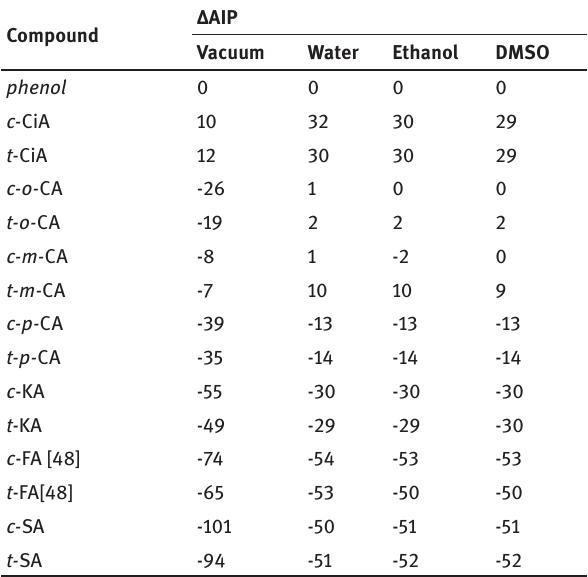
Table 6: Δ AIP [kJ mol -1 ] values calculated with B3LYP/6-311++G(2d,2p) level of